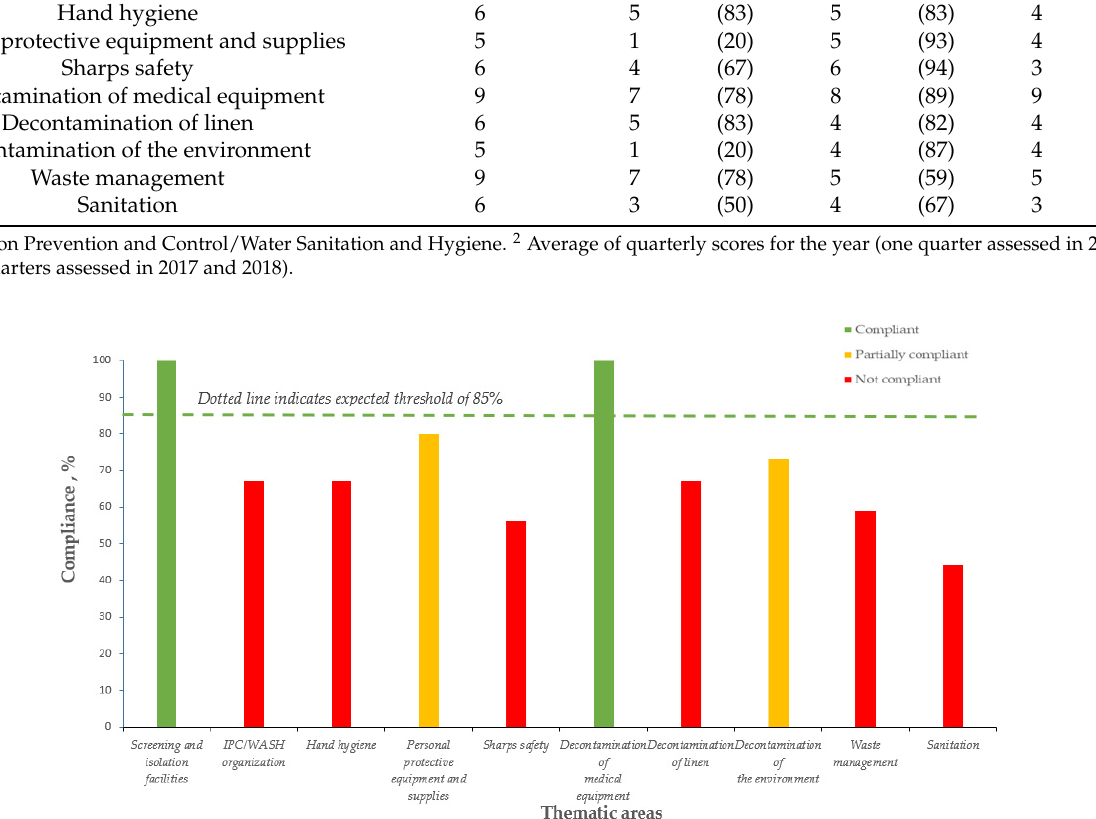
Figure 1. Average yearly IPC/WASH compliance in the 10 thematic areas, Kenema district hospital, Sierra Leone (2018).